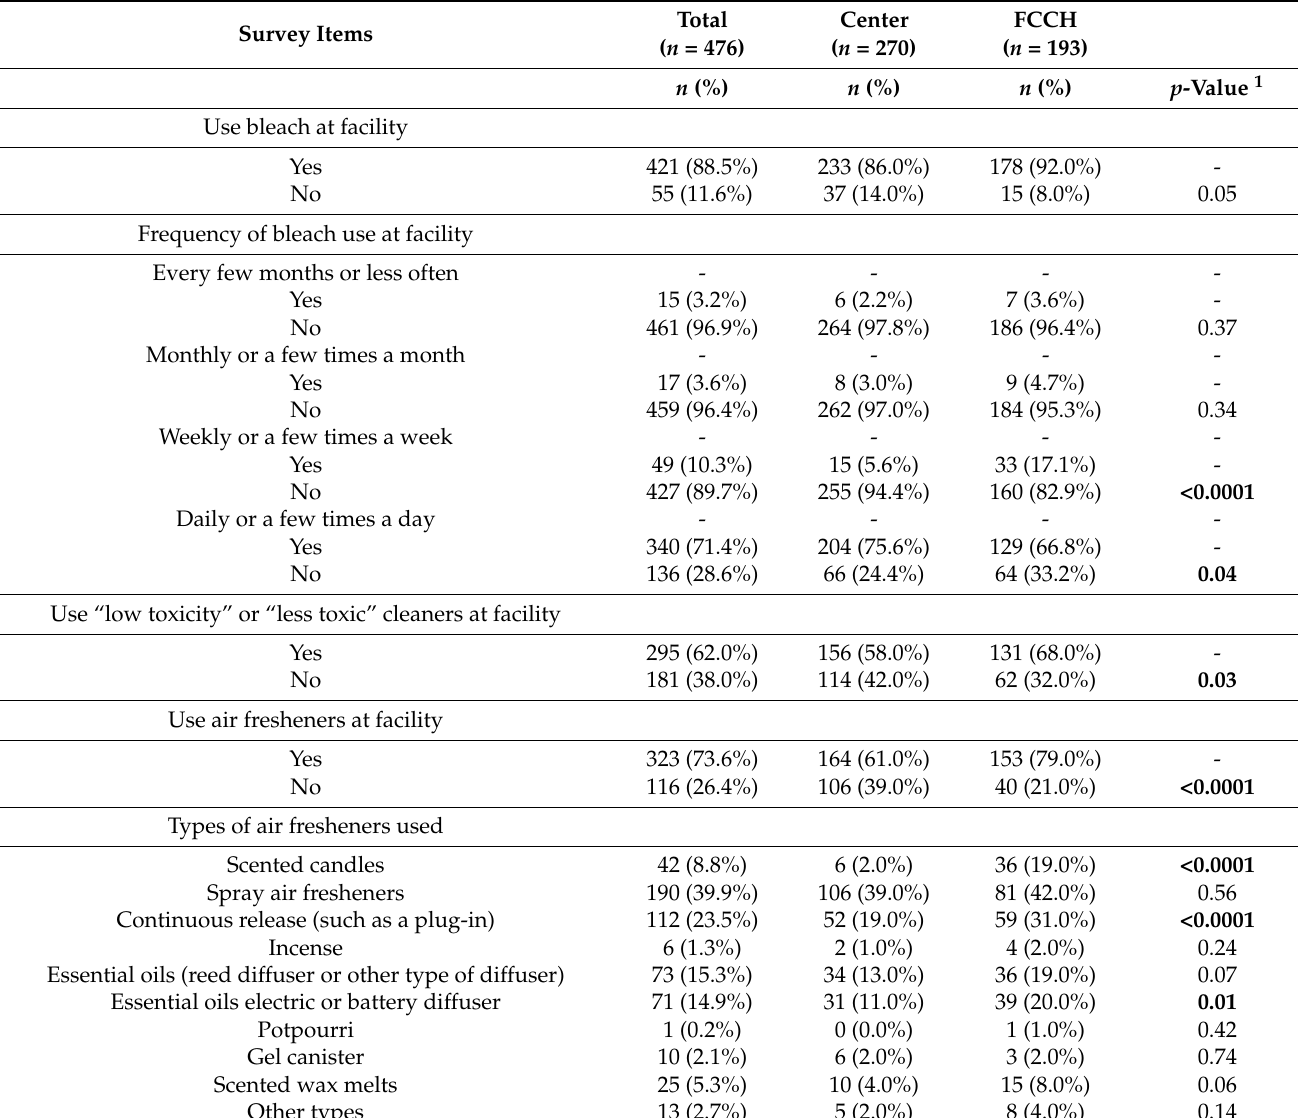
Table 3. Reported use of bleach, air fresheners, and cleaners for all early care and education programs, centers, and family childcare homes (FCCHs), Oklahoma 2019–2020.